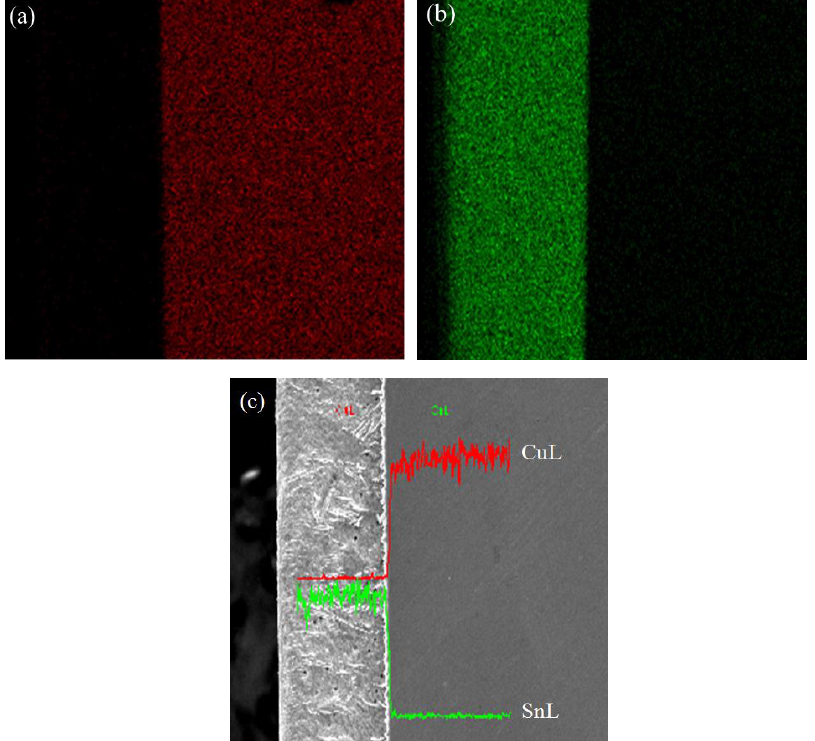
Figure 3. Element distribution of hot-dipped specimen processed with pretreatment parameter No.6: ( a ) distribution of Cu, ( b ) distribution of Sn, and ( c ) energy-dispersive spectroscopy (EDS) spectra and elements quantification.